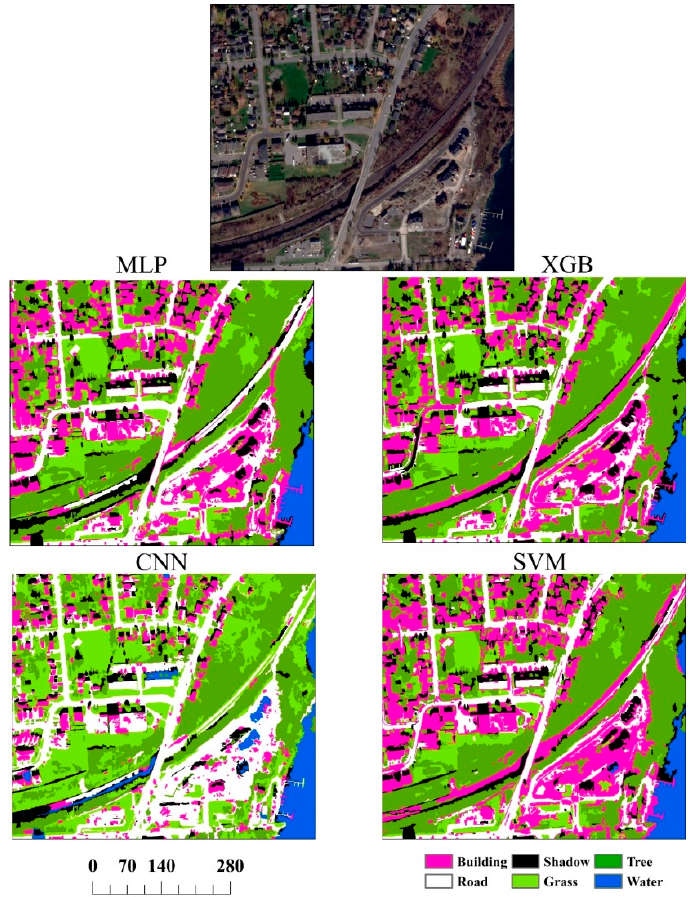
Figure 4. Subsets of classification maps generated by the MLP, XGB, CNN, and SVM models for the 50 cm image.